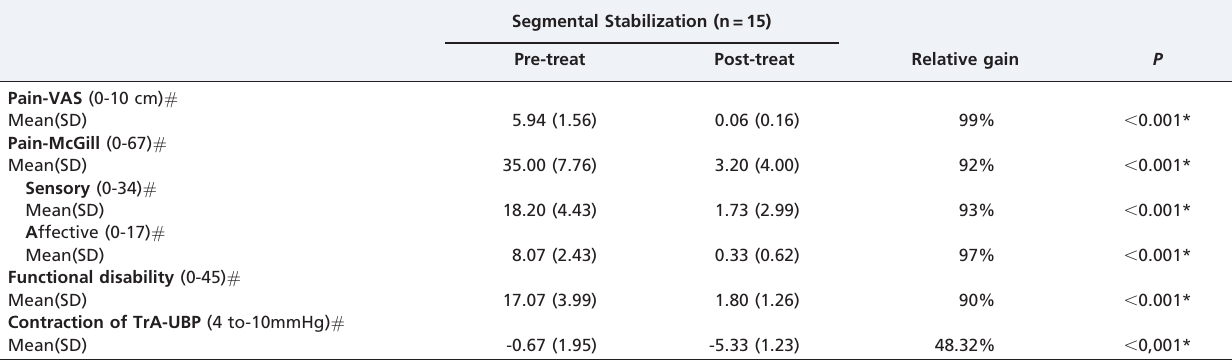
Table 3 - Pain, functional disability and contraction of TrA mean values of SS group at pre- and post-treatment evaluations, and p values.